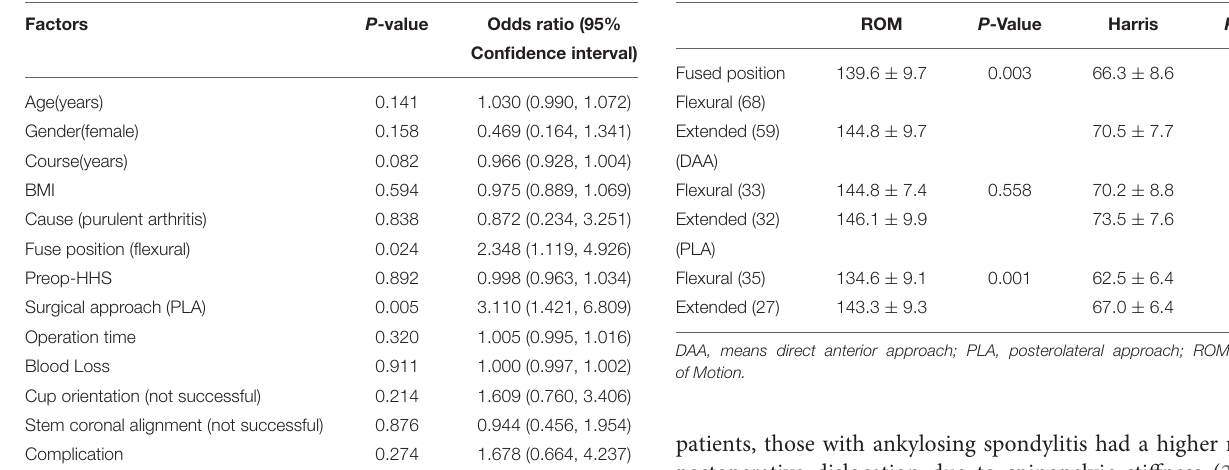
TABLE 3 | Summary of multivariable ordinal logistic regression for 1 month follow-up.